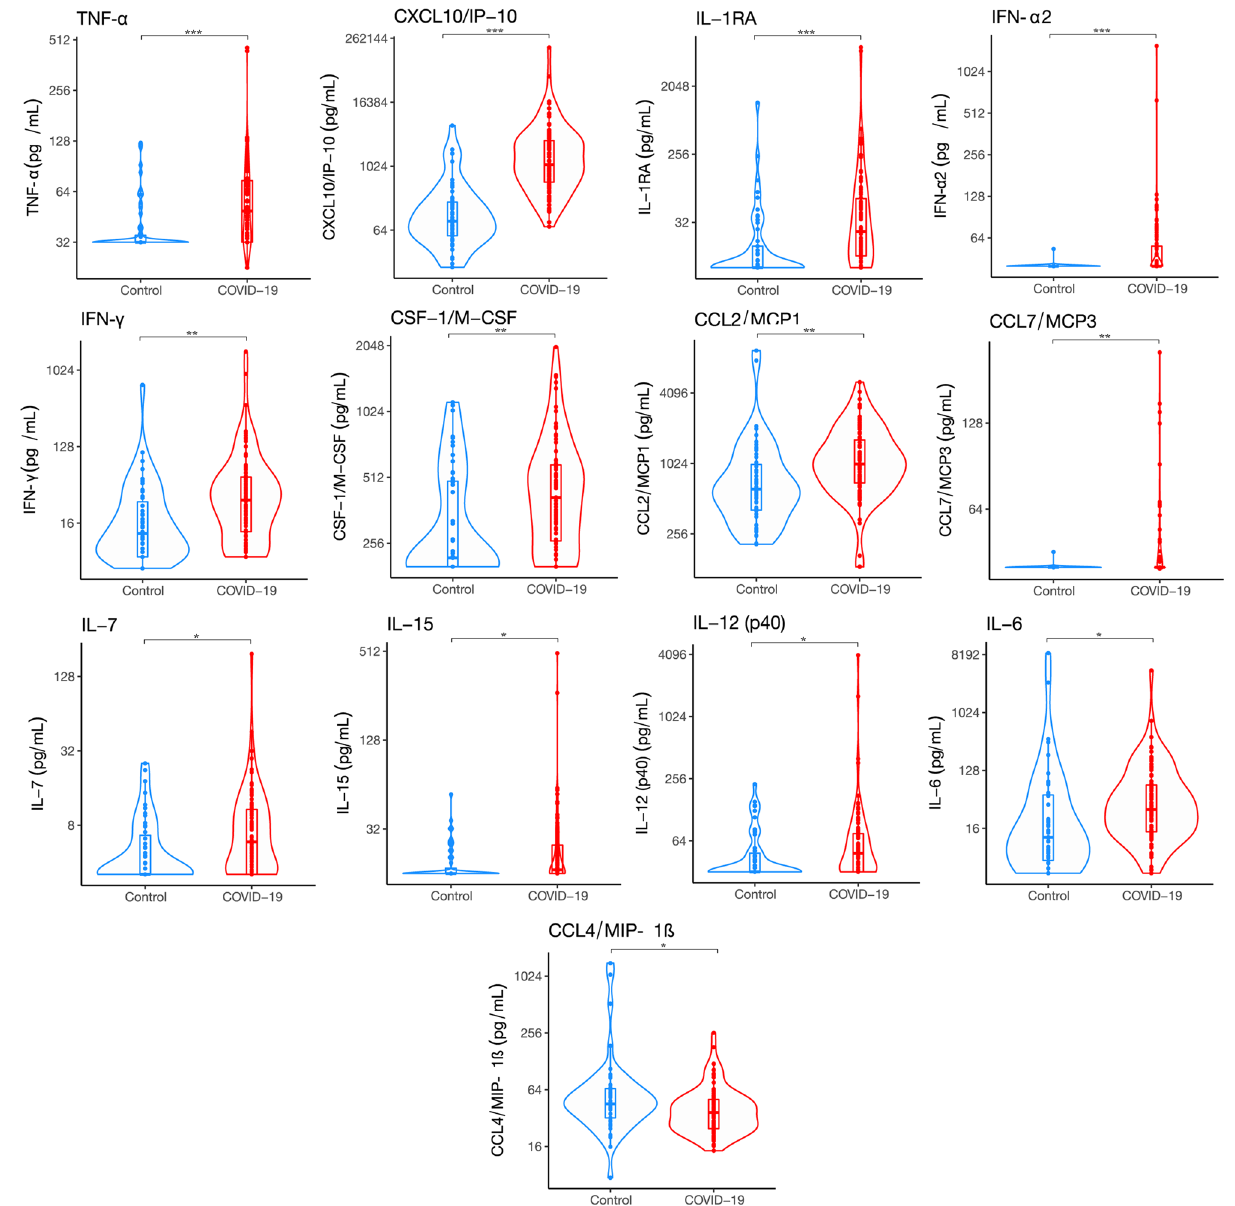
Figure 1. Cytokine expression of COVID19 and control patients. The curved line of the violin box plots show the density of day 1 of hospital admission cytokine expression levels. The horizontal line in the inner box plot represents the median and interquartile range. Each dot represents a subject (COVID19, n = 90; Control, n = 51). Significance of comparisons were determined by an unadjusted linear regression models using log- scaled cytokines and robust standard errors. P-values after adjustment for multiple comparisons accompany the respective comparisons. *p < 0.05, **p < 0.01, ***p <